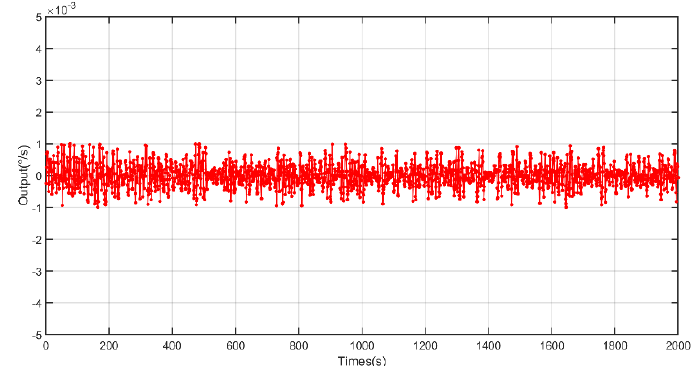
Figure 21. Signal reconstructed based on ELM ( − 40 °C −6 0 °C).